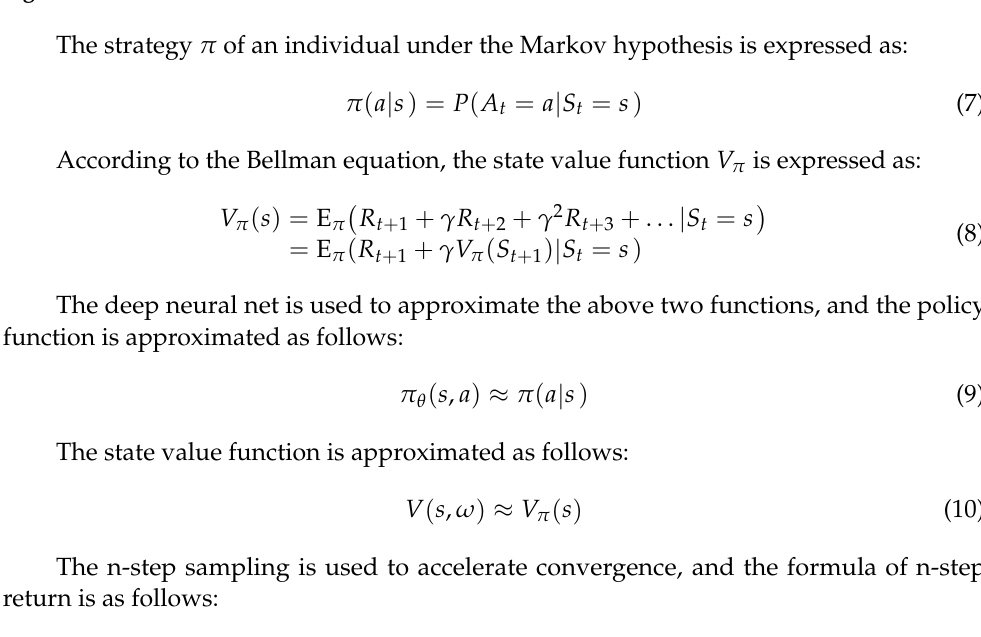
Figure 4. The Actor–Critic network